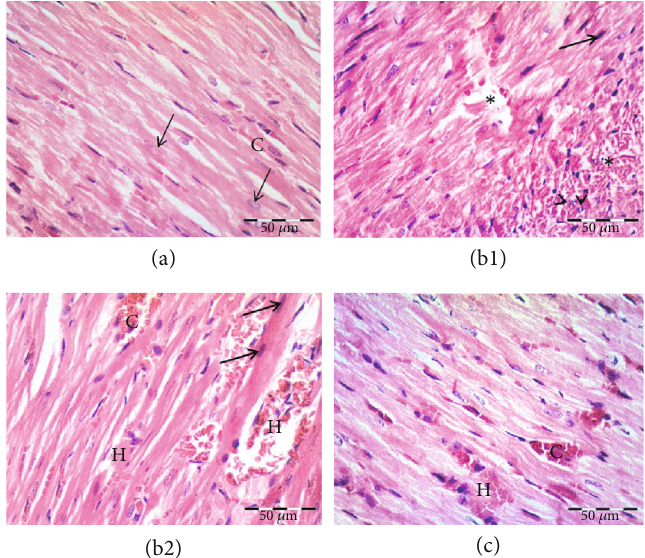
Figure 1: E ff ect of paeonol on histopathological changes in methotrexate- (MTX-) induced cardiac toxicity in rats. (a) Control group showing branched striated cardiac muscle fi bers with acidophilic cytoplasm and central, vesicular, and oval nuclei (arrows). Notice the blood capillaries between the muscle fi bers (C). (b1 and b2) MTX-treated group showing area of widely separated and fragmented necrotic cardiac muscle fi bers ( ∗ ), congestion (C), and hemorrhage (H). Notice apoptotic muscle fi bers, some with hyperacidophilic cytoplasm and pyknotic nuclei (arrows), others showing fragmented nuclei (arrowheads). (c) Paeonol+MTX group showing cardiac muscle fi bers that appear more or less normal. Notice dilated congested blood capillaries (C) between the cardiac muscle fi bers and area of hemorrhage